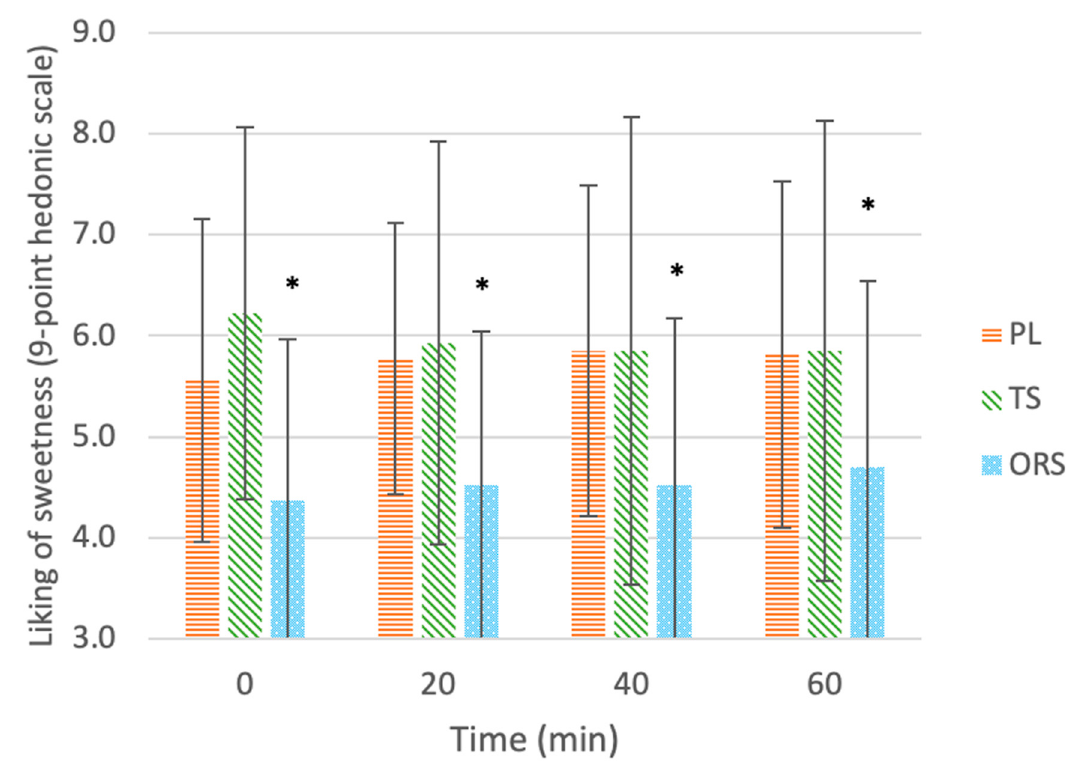
Figure 3. Liking of sweetness of drinks: ORS—oral rehydration solution, PL—placebo, TS—traditional sports drink, on a 9-point hedonic scale throughout 60 min of exercise. Values are mean ± SD. * Significant effect of the treatment vs. the placebo ( p < 0.05).